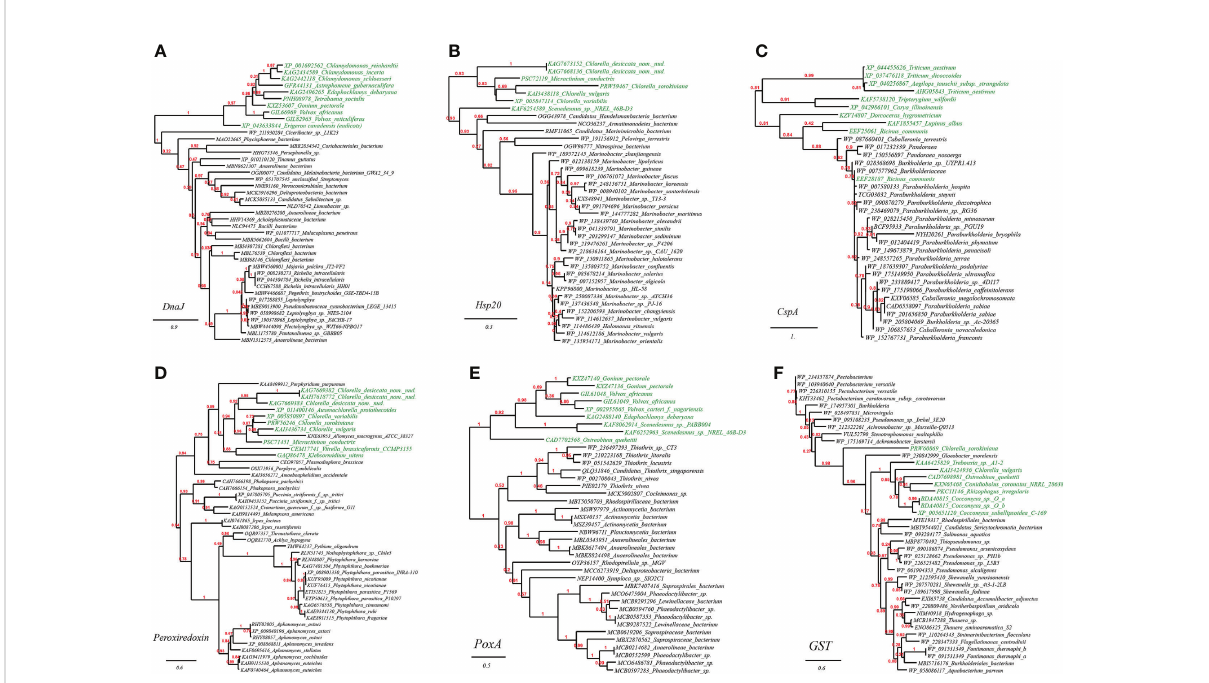
FIGURE 3 Phylogenetic tree of heat and cold stress as well as oxidative stress resistance proteins in plant genomes originated from microbial taxa. The phylogeny construction was conducted based on gene-translating protein sequences using PhyML program with the Maximum Likelihood (ML) method and 1,000 bootstrap replicates (with bootstrap values in red showing on respective branches). Branches leading to plant taxa are marked by green color, whereas those belonging to microbial lineages are in black: (A) heat-shock protein DnaJ; (B) heat shock protein Hsp20; (C) cold-shock protein CspA; (D) peroxiredoxin; (E) heme peroxidase (PoxA); (F) glutathione S-transferase